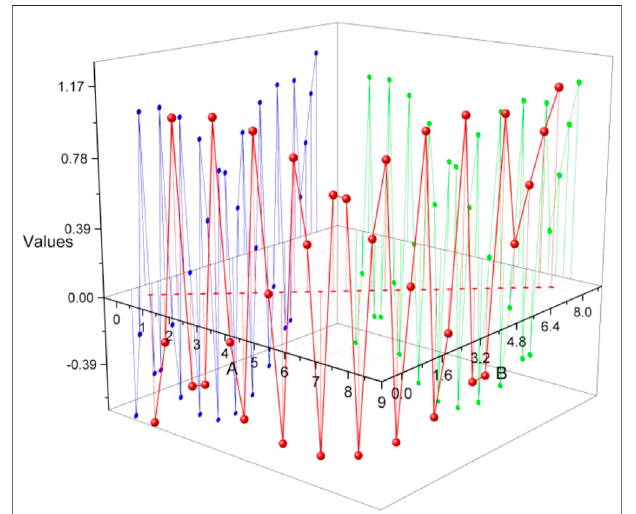
FIGURE 10 | Results of SEMG signal feature extraction in the lower computer.